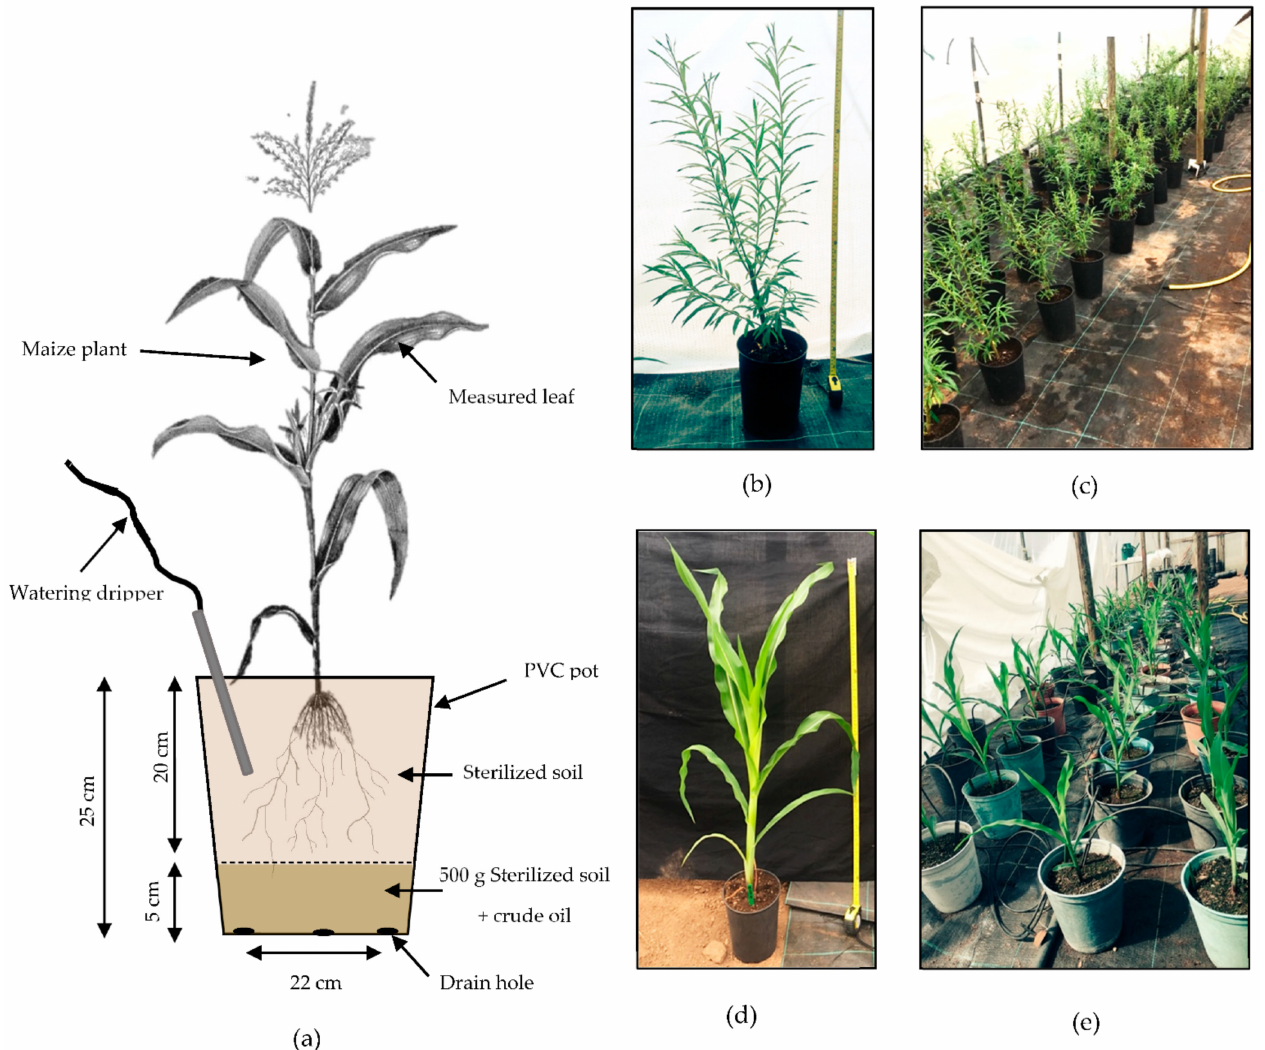
Figure 2. ( a ) Schematic diagram of a maize plant set up in the experiment. ( b ) Willow tree after 8 weeks of growth before the addition of the crude oil polluted layer (1 m tape). ( c ) Distribution of willow trees in the polytunnel during the experiment. ( d ) Maize plant after 5 weeks of growth with no crude oil pollution layer in the pot (1 m tape). ( e ) Distribution of maize plants in the polytunnel during the experiment. (Plant diagram modified from https://upload.wikimedia.org/wikipedia/ commons/0/0c/PSM_V82_D230_Maize_and_its_proposed_asiatic_origin.png, accessed on 12 May 2021; unknown author, public domain via Wikimedia